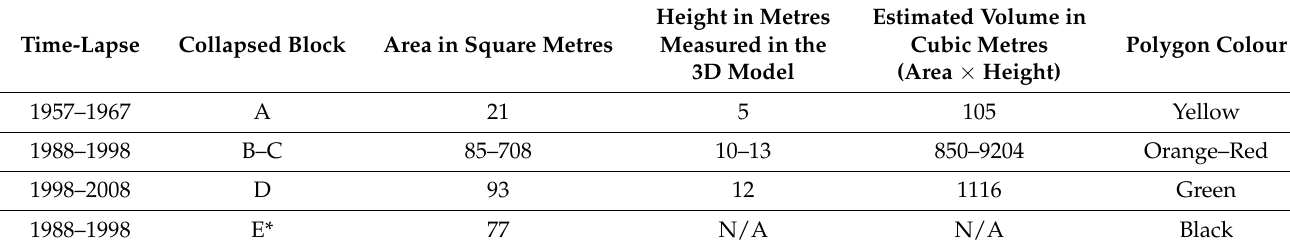
Table 2. Summary of the multitemporal analysis. E* is the boulder on the slope that fell apart between 1988 and